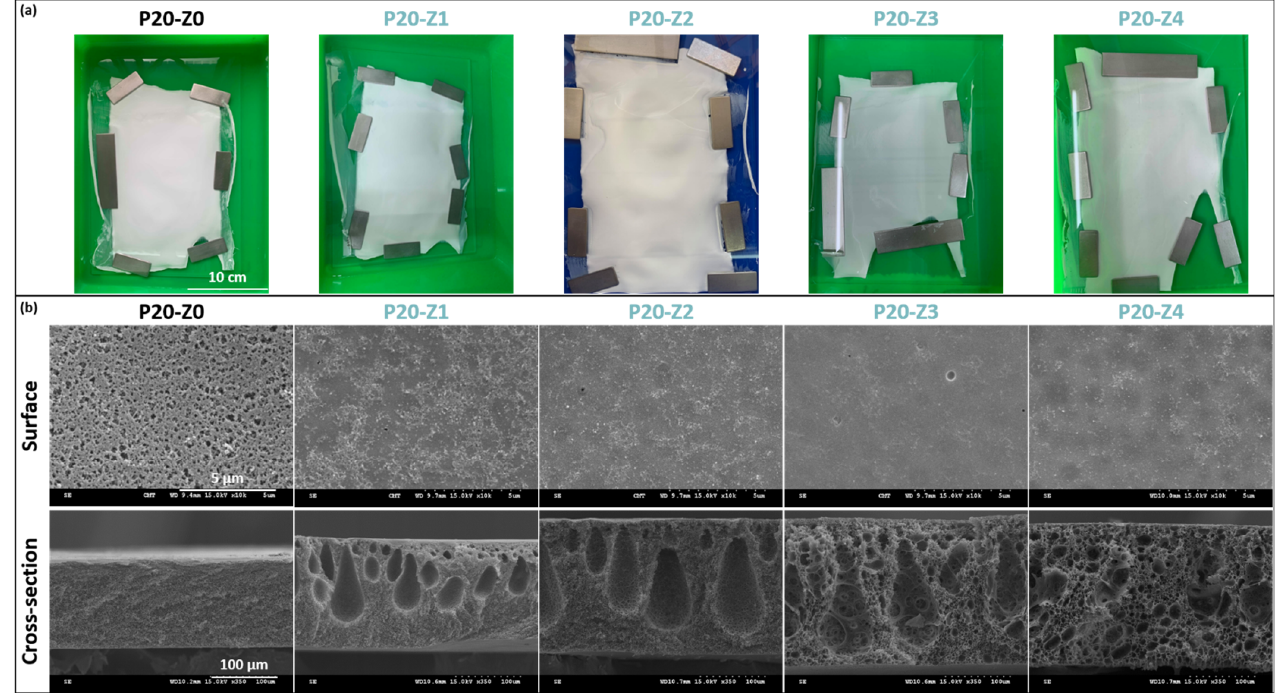
Figure 3. Physical characterization of membranes’ structure. ( a ) Photographs of virgin and zwitter- ionic membranes; ( b ) SEM analysis of surface and cross-section of virgin and zwitterionic mem- branes.